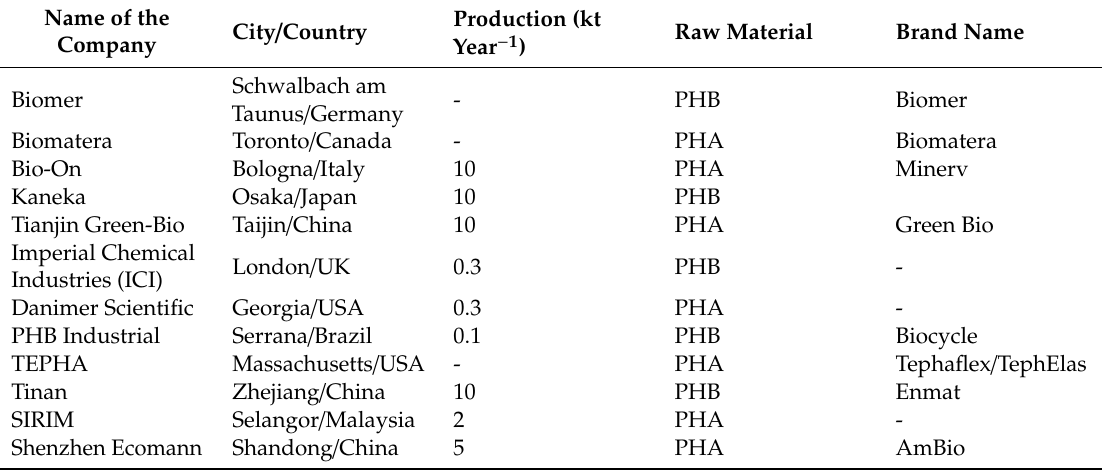
Table 2. Global manufacturers of PHB / PHA (http: // www.european-bioplastics.org / ;